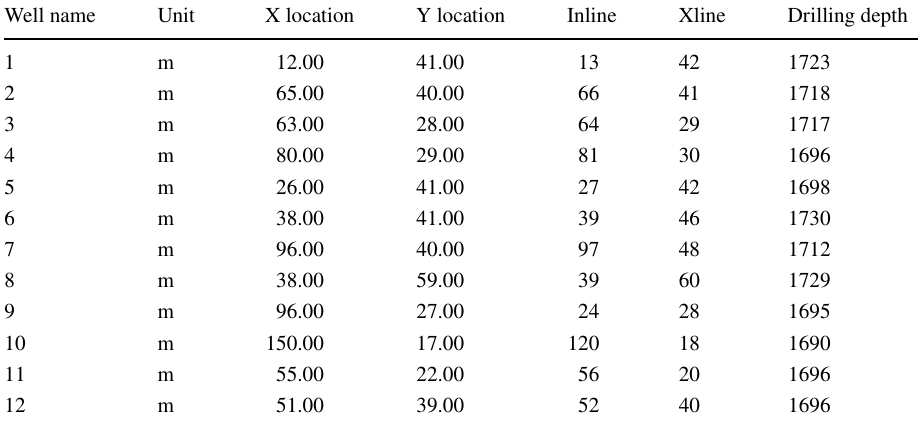
Table 1 Specifications of wells drilled in the oil